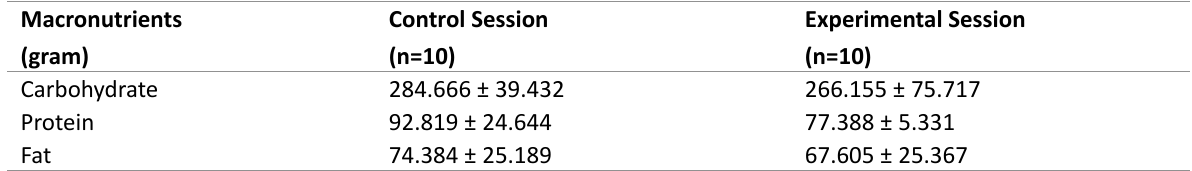
Table 3. Macronutrients intake in the control and experimental session throughout the day (Mean±SD).